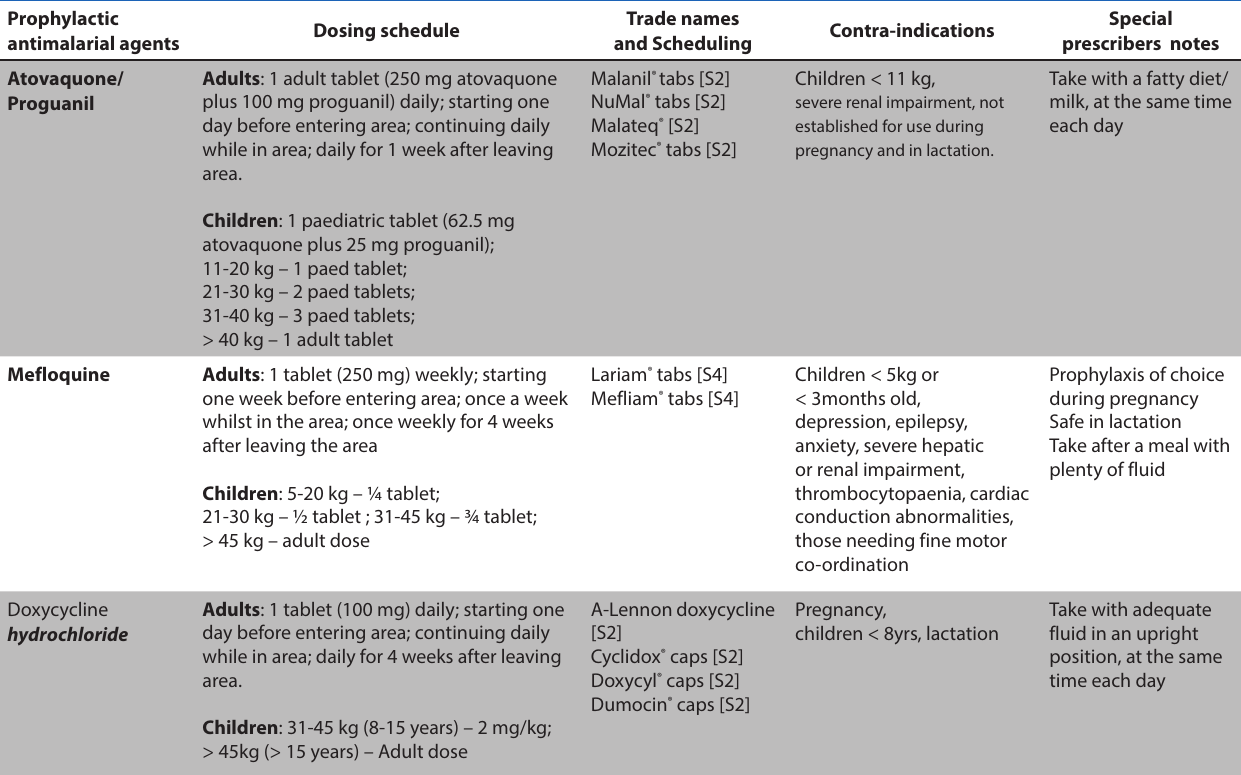
Table I: Pharmacological profile of prophylactic drugs to be taken at the same time each day. 1,10,11 Prophylactic Dosing antimalarial agents